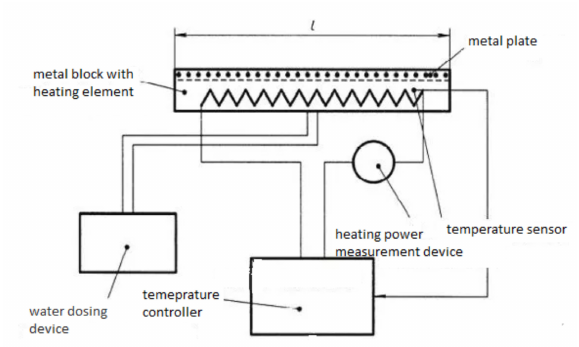
Figure 4. Device for the determination of the thermal resistance of fabrics.